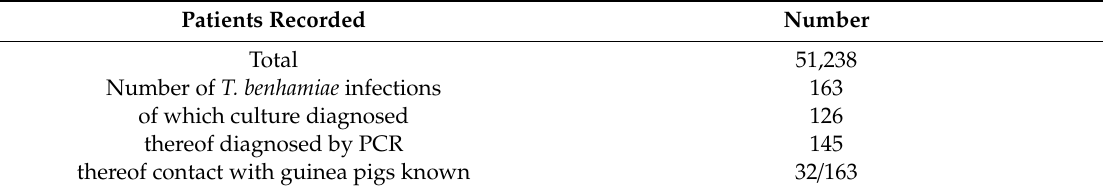
Table 5. Evaluation of questionnaires on recorded human T. benhamiae infections,